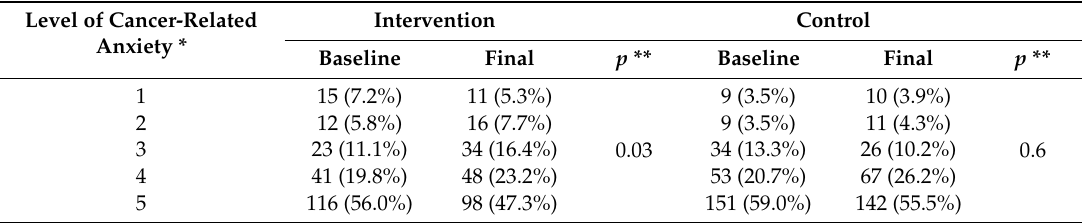
Table 3. Di ff erences in the level of anxiety associated with selected diseases: baseline and final assessment in intervention and control groups in terms of numbers and percentages (in